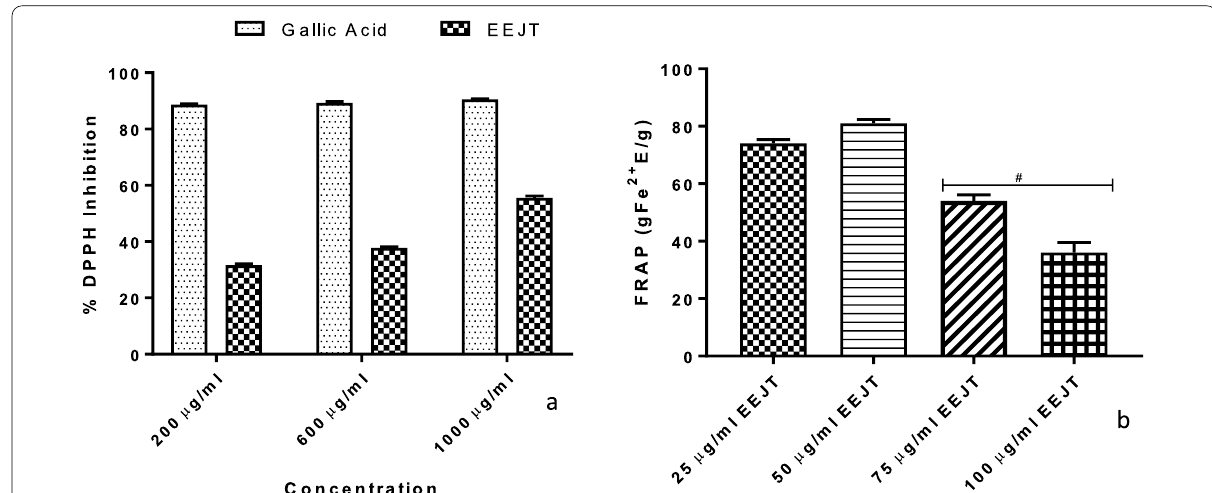
Fig. 6 In vitro antioxidant potential of ethanol extract of Jatropha tanjerensis leaves ( a ) DPPH scavenging ability ( b ) Ferric reducing antioxidant power (FRAP) # p < 0.05, considered significant compared with 25 µg/mg EEJT